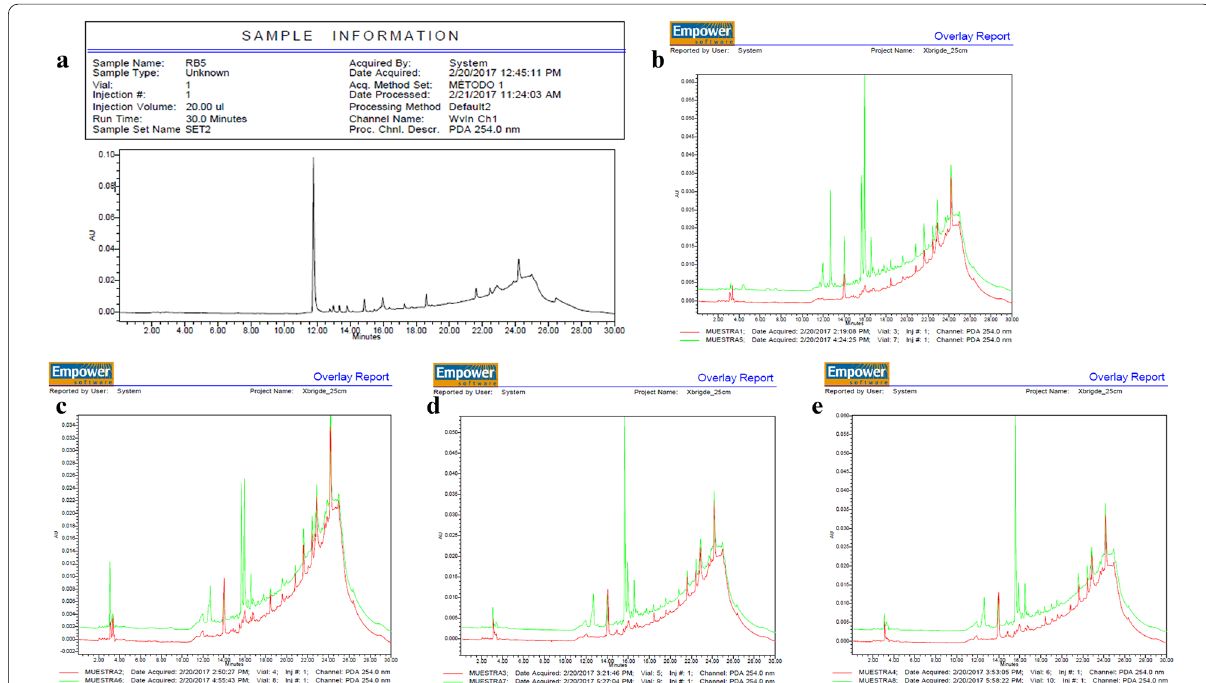
Fig. 3 Chromatograms of the ethyl acetate extracts of supernatants at the final time point in the culture of Leucosporidium muscorum F20A supplemented with 200 mg L –1 of RB-5. The sample number and color code, the date, and other information pertaining to the run is provided below each chromatogram. For an explanation of the significance of the various peaks illustrated by the runs represented in the five panels, cf . the